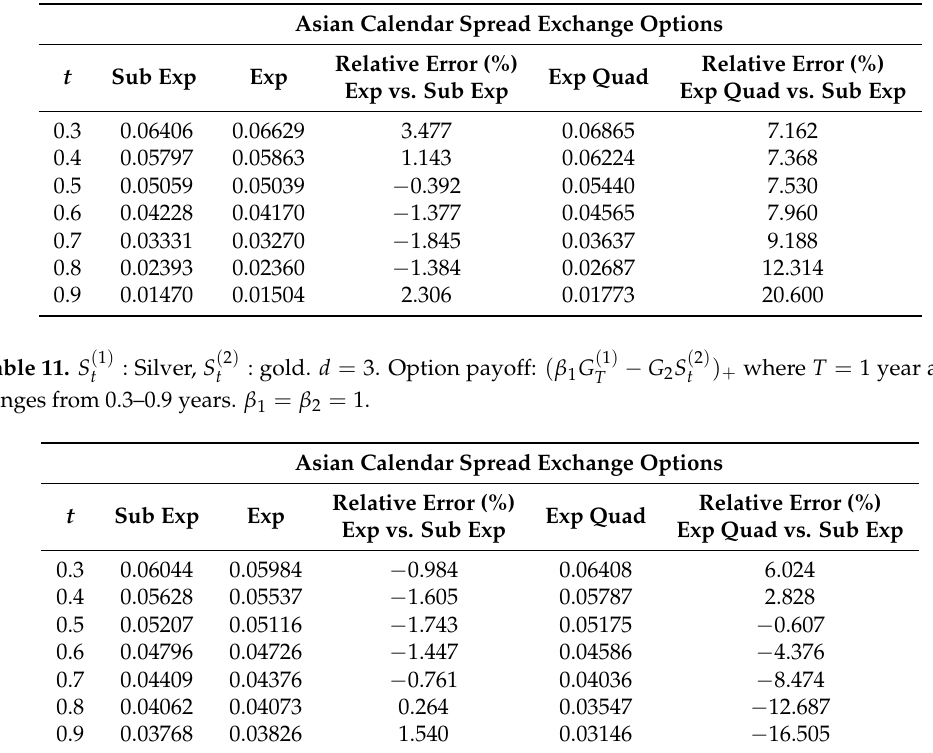
ranges from 0.3–0.9 years. β 1 = β 2 = 1.